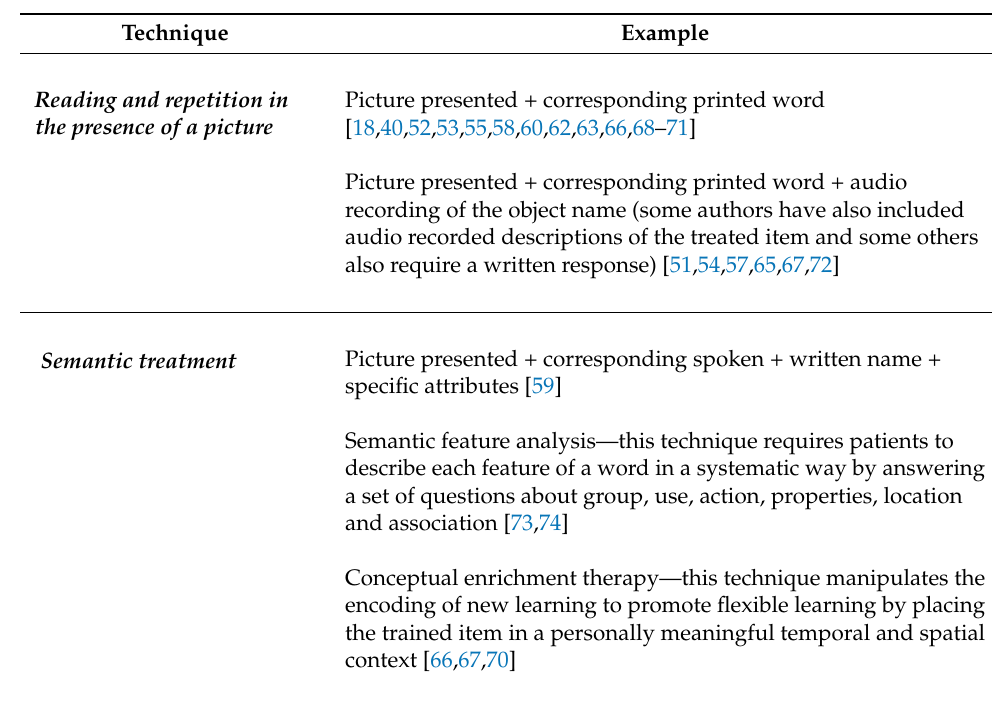
Table 2. List of lexical retrieval techniques used in the svPPA rehabilitation